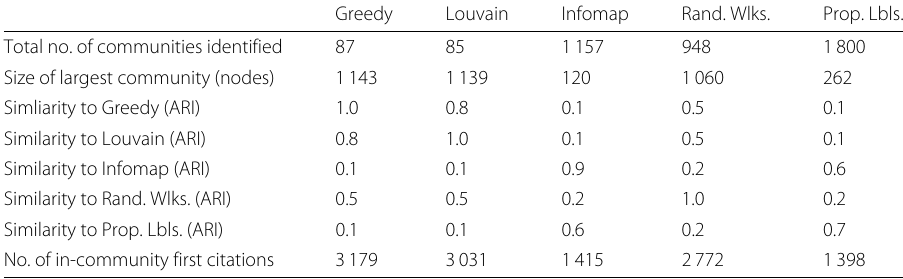
Table 3 Comparison of inventor-community structures found by different algorithms Greedy Louvain Infomap Rand. Wlks. Prop. Lbls. Total no. of communities identified 87 85 1157 948 1800 Size of largest community (nodes) 1143 1139 120 1060 262 Simliarity to Greedy (ARI) 1.0 0.8 0.1 0.5 0.1 Similarity to Louvain (ARI) 0.8 0.5 Similarity to Prop. Lbls. (ARI)